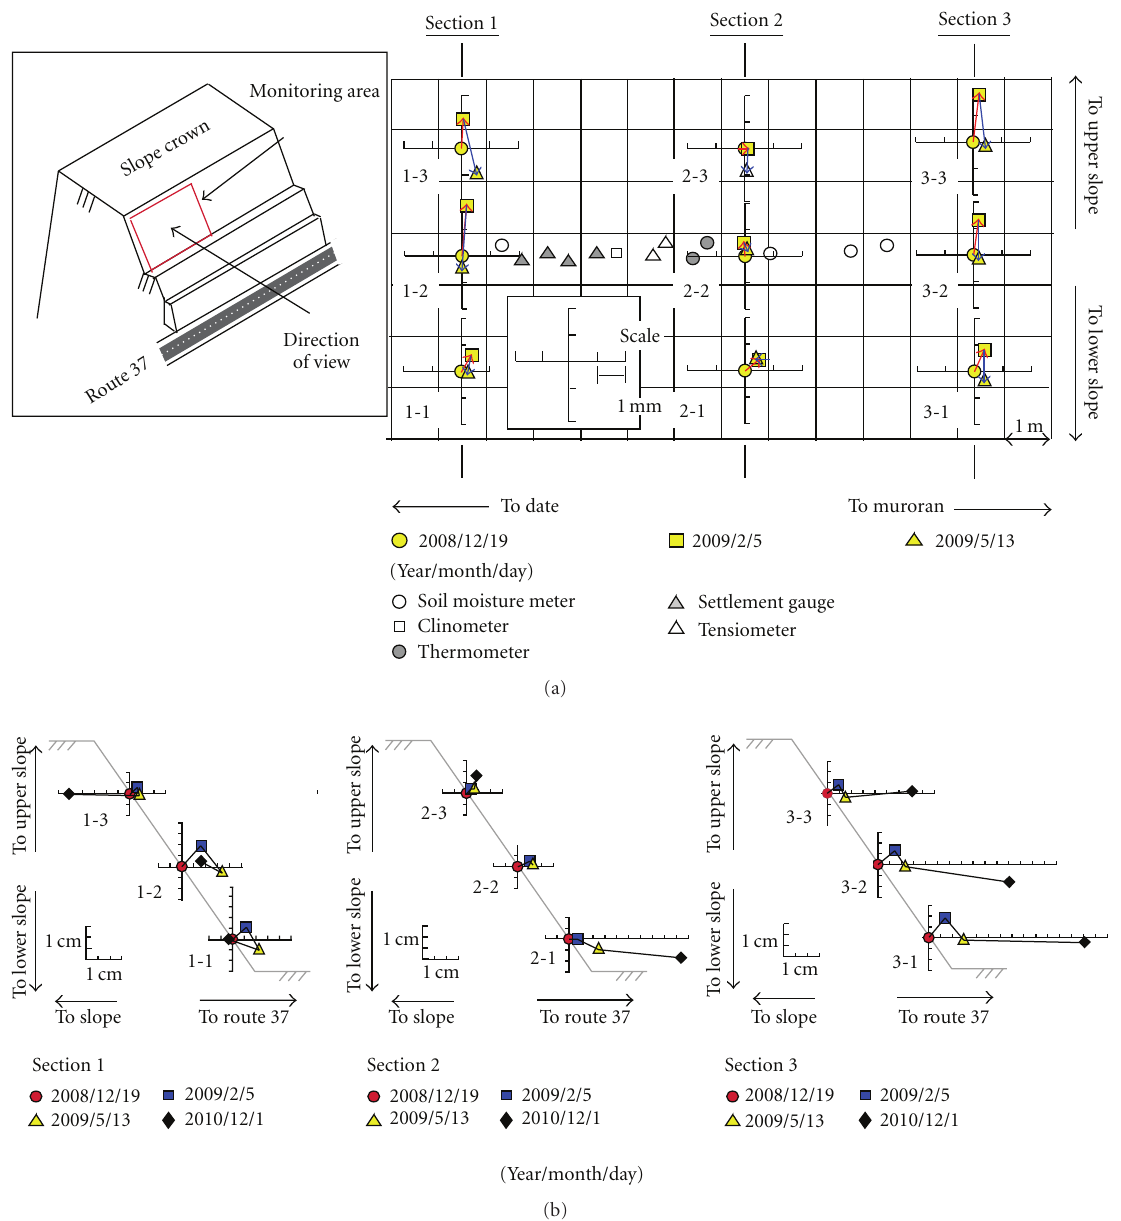
Figure 13: Surveying results for monitoring site; (a) plane section, and (b) cross